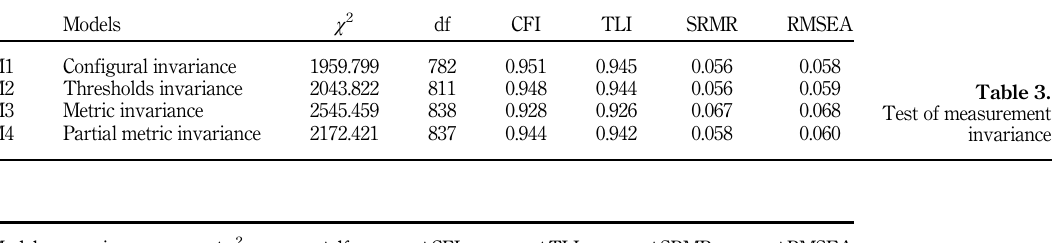
Table 4. The comparison of